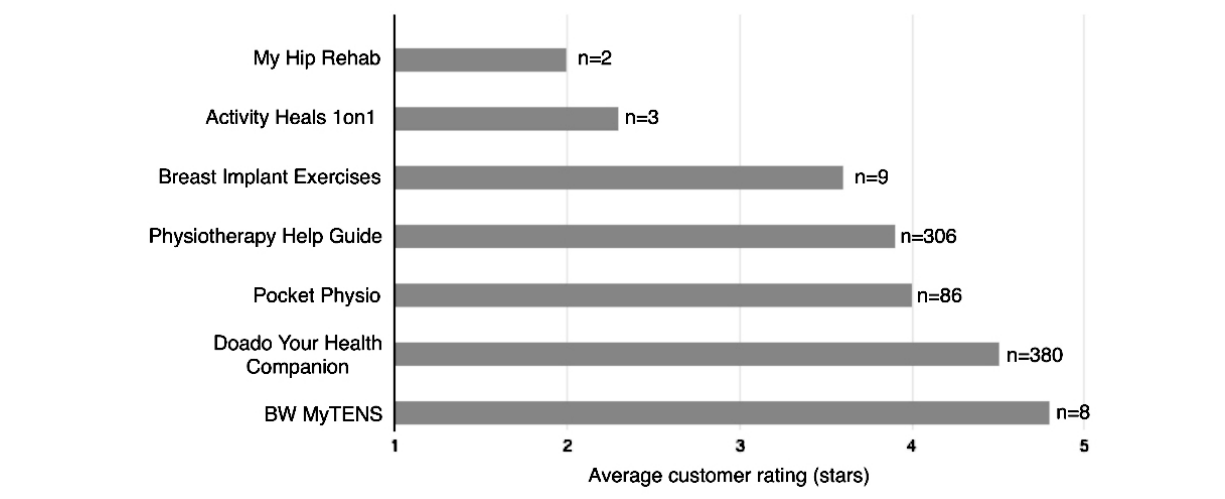
Figure 3. Customer-generated app ratings. *No customer ratings, or less than 2 ratings, were available for three apps: Fuse – Post-Op Journal, Surgeon on Call, and Healing